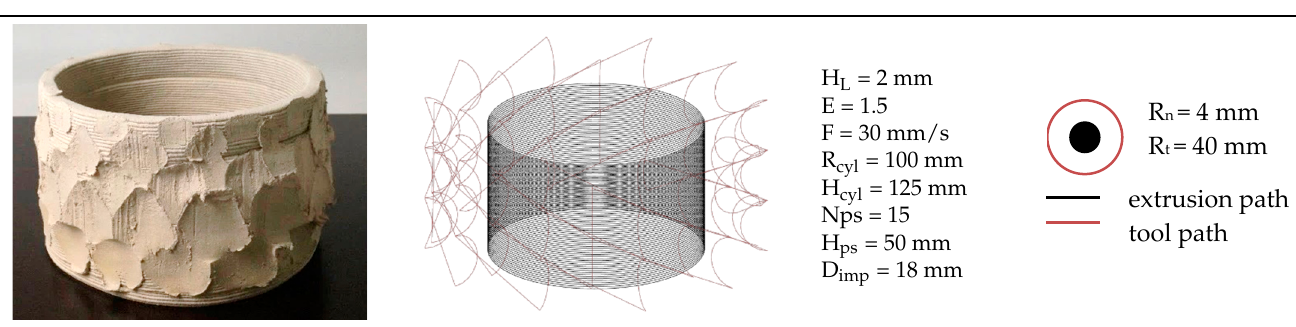
Table 6. Comparison of Grasshopper modelling as complex path instruction (material extrusion + tool) and materialized implementation with cutting tool and round material stencil in the LDM of clay.